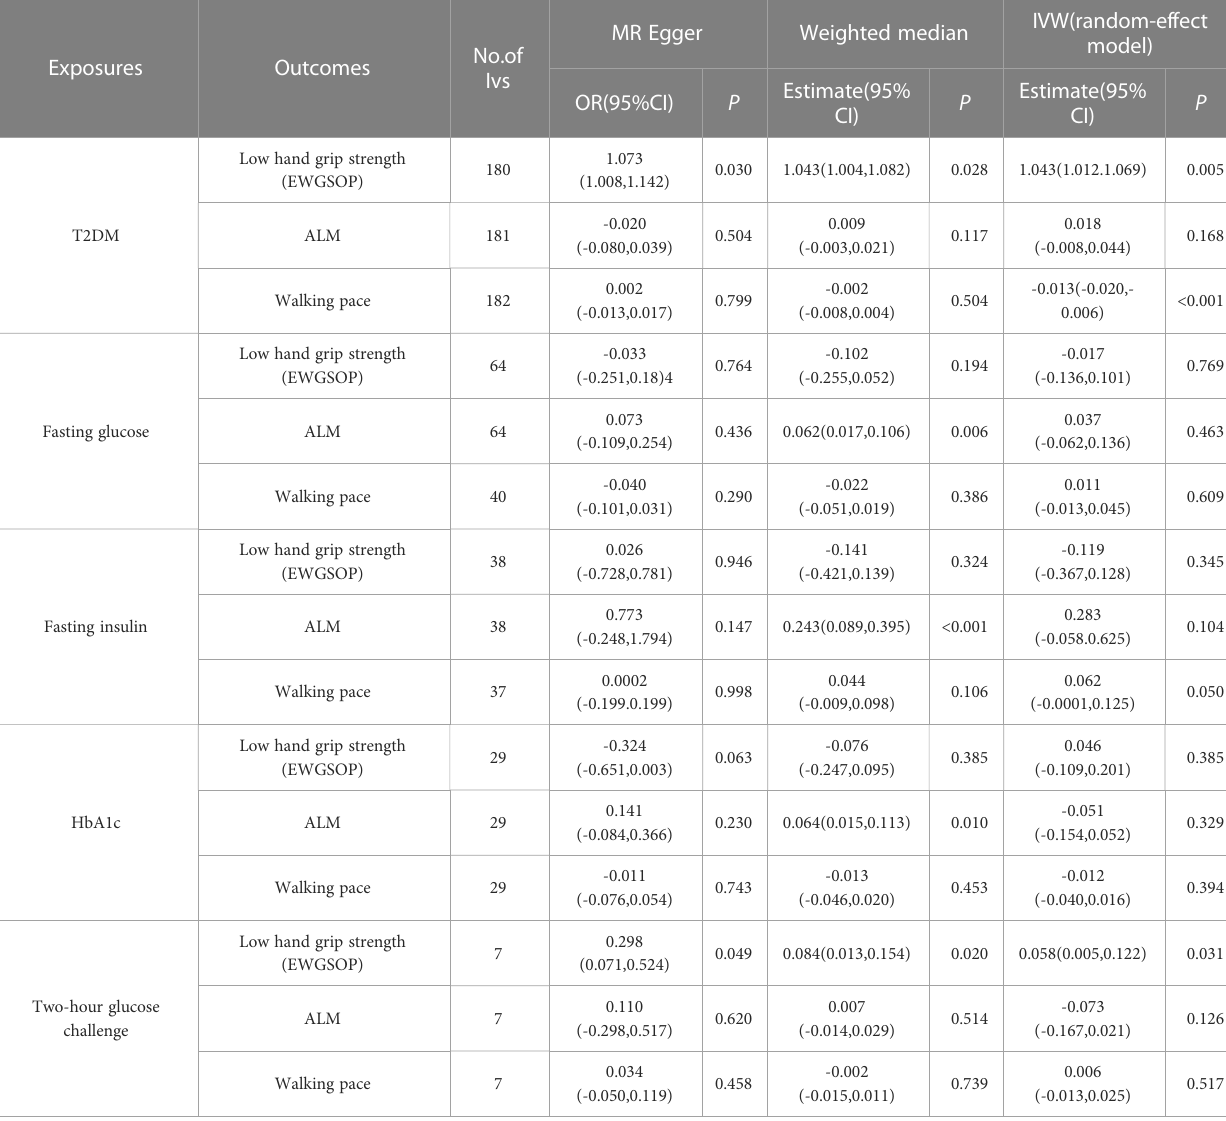
TABLE 6 Association T2DM and glycaemic traits with sarcopenia-related traits using Mendelian randomization.